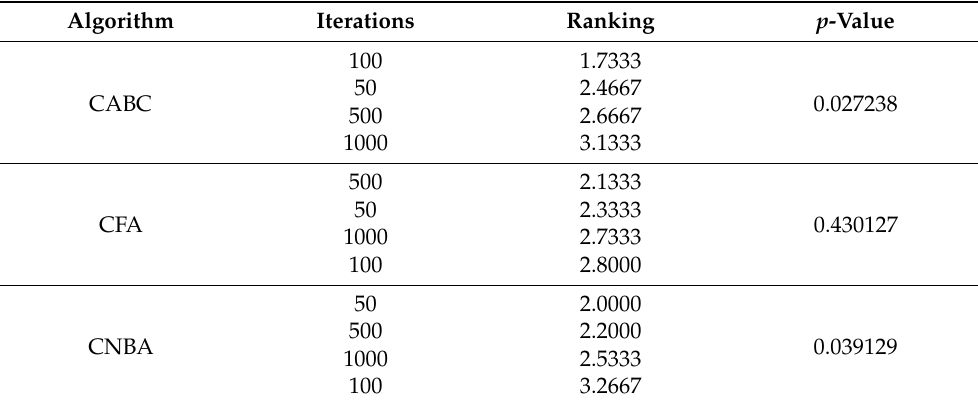
Table 2. Ranking of Friedman test comparing the results of the proposed algorithms with different iteration number, according to ARI measure.